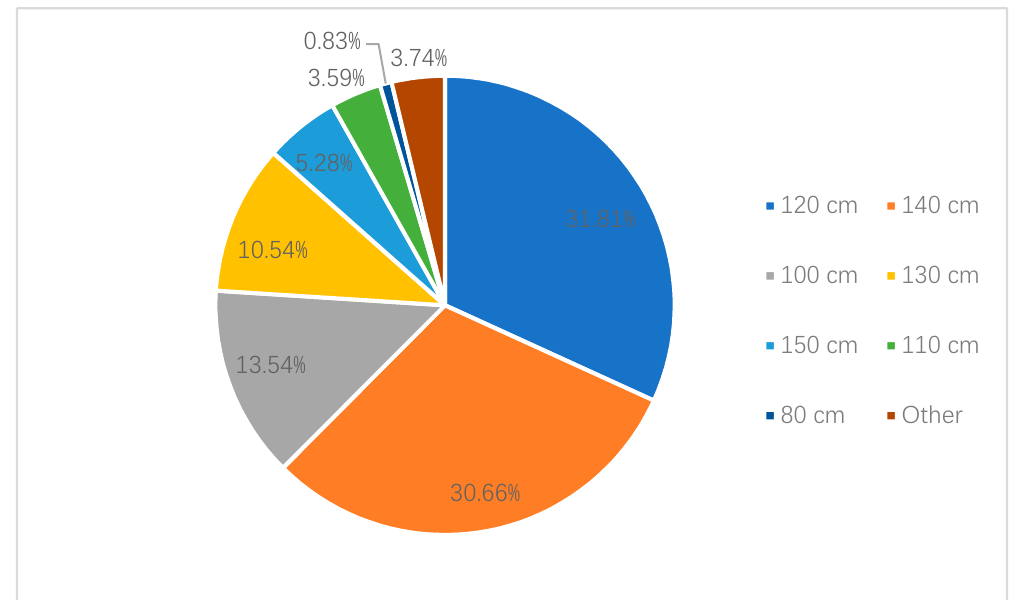
Figure 1. Recognized age criteria of national child restraint legislation by parents in Shanghai.